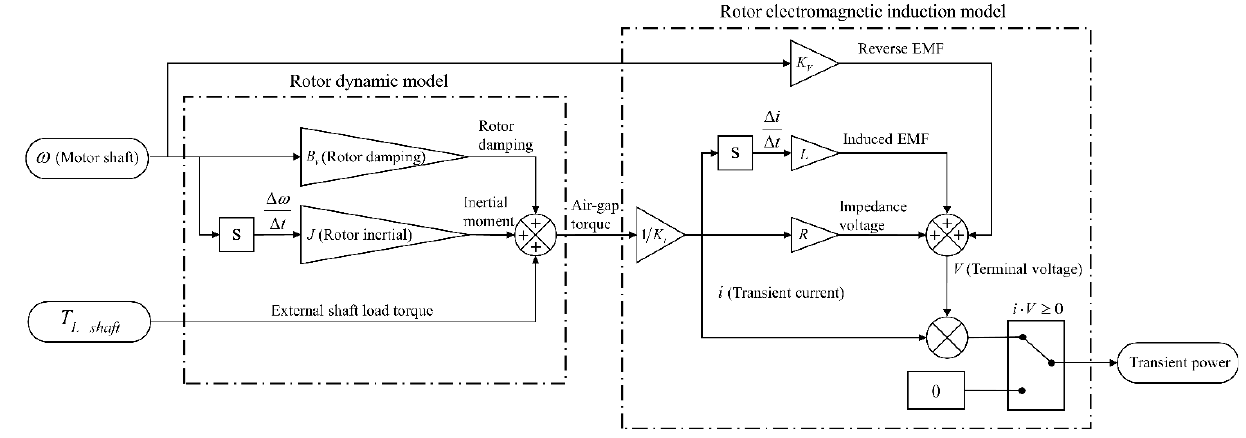
Figure 5. The schematic diagram of the DC motor electric consumption model.